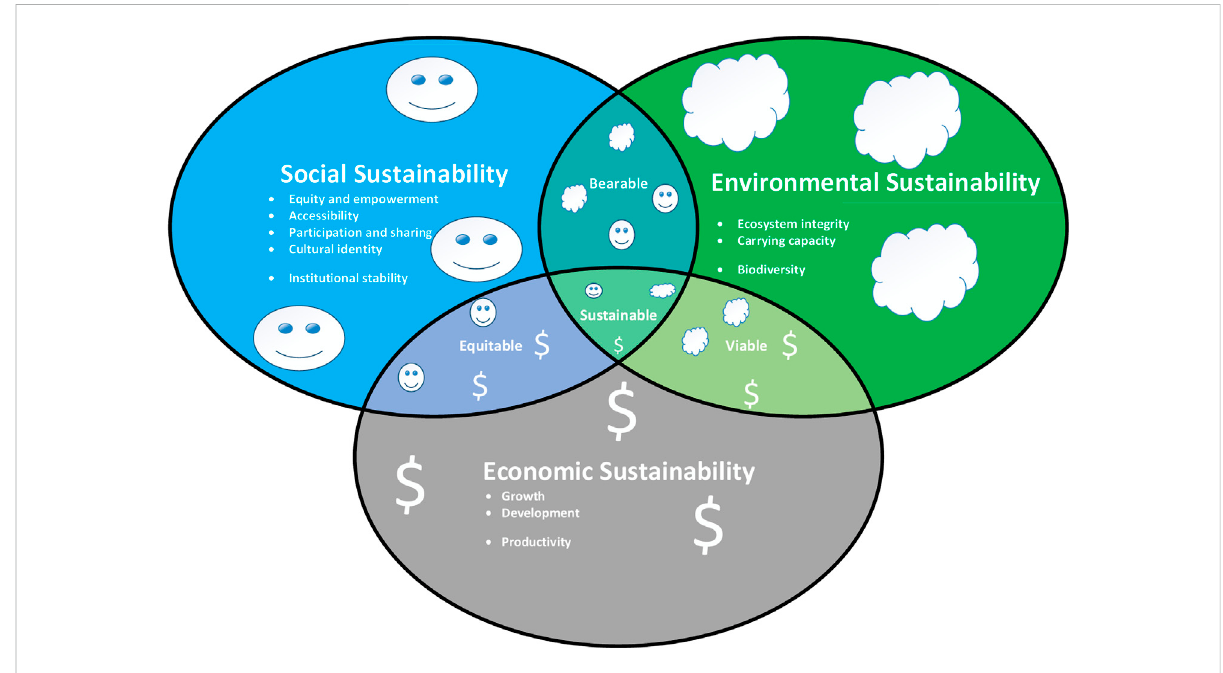
FIGURE 3 Sustainable development. Mcguinn et al., 2020.